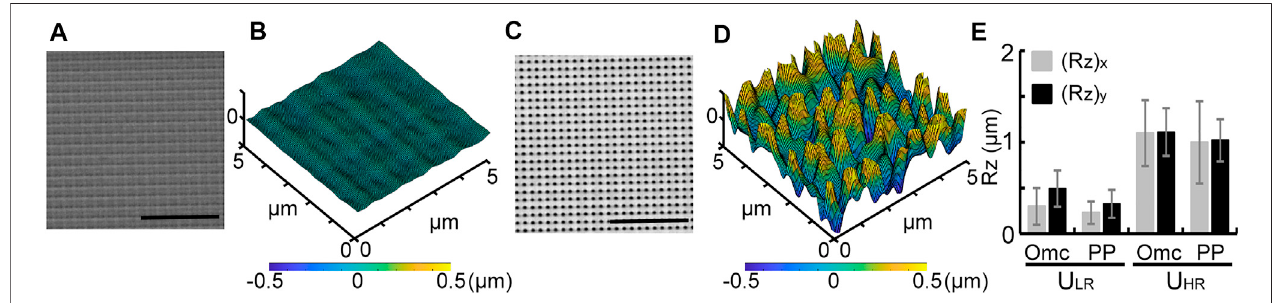
Frontiers in Cell and Developmental Biology |